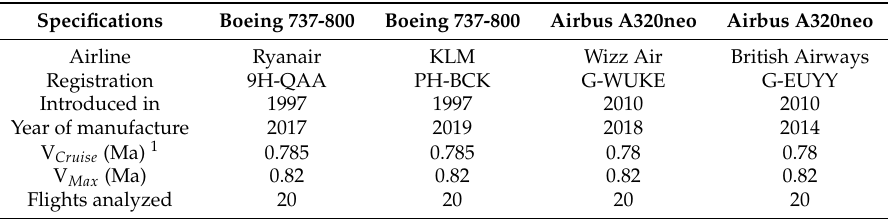
Table 2. Aircraft analyzed using Flightradar24.